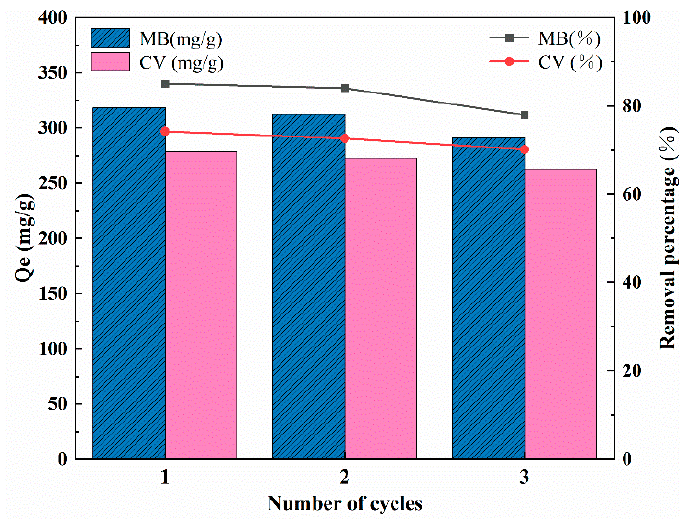
Figure 8. Reusability of MT for the adsorption of MB and CV.